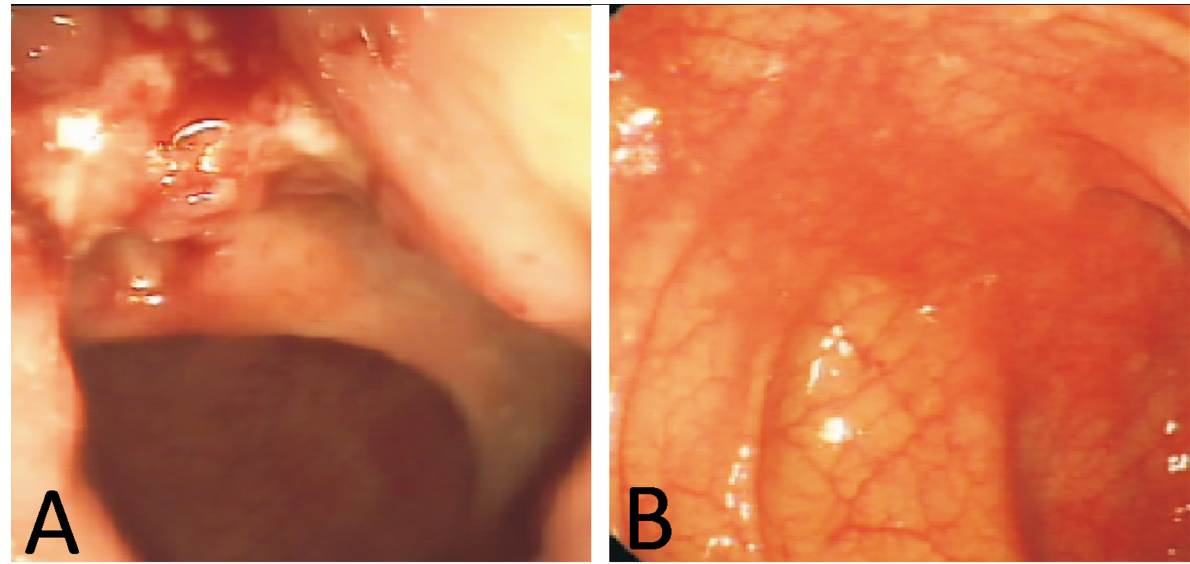
Fig. 1. Endoscopic images of the rectum. (A) Sigmoidoscopic findings indicate the rectal chancre was located on the posterior wall of the rectum. (B) Follow-up sigmoidoscopy after 2 months revealed incomplete regression, leaving a slight thickening of the wall and grainy hyperplasia at the ileocecal junction.